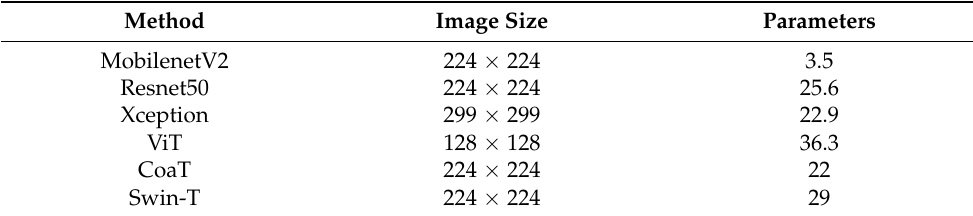
Table 1. Values of the parameters used in the classifiers